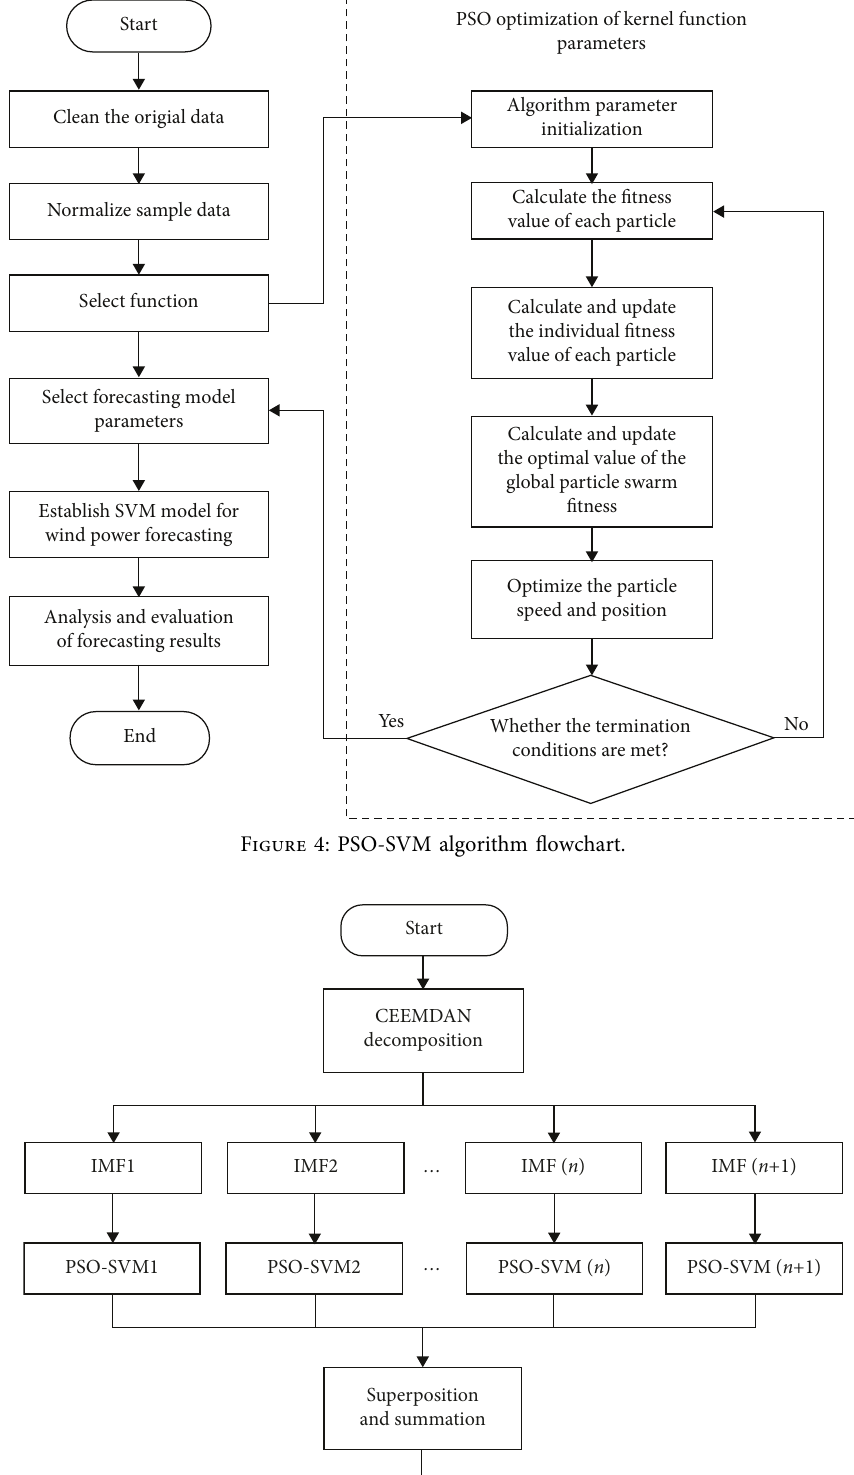
Figure 5: CEEMDAN-PSO-SVM forecasting